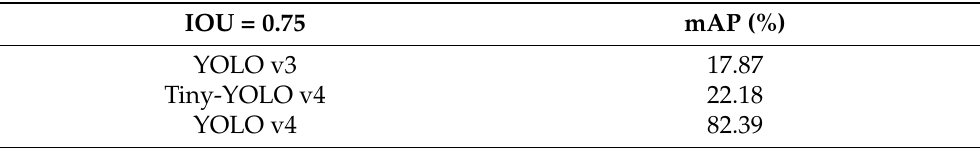
Table 6. Performance of the compared algorithms when the IOU value was 0.75.